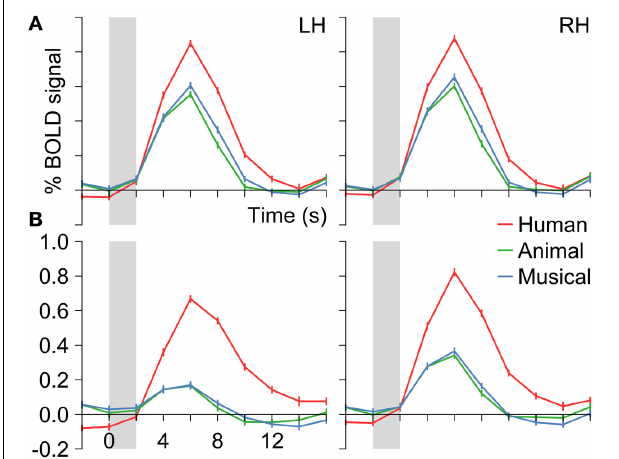
FIGURE 4 | Group BOLD time courses for the contrasts (A) Human voices > Rest ( H + ) and (B) Human voices > Animal sounds + Musical instruments (conjunction of H + and 2 H > A + M ) averaged over the activated voxels in the temporal lobes (see Figure 3). Gray bars indicate the period of stimulus presentation.